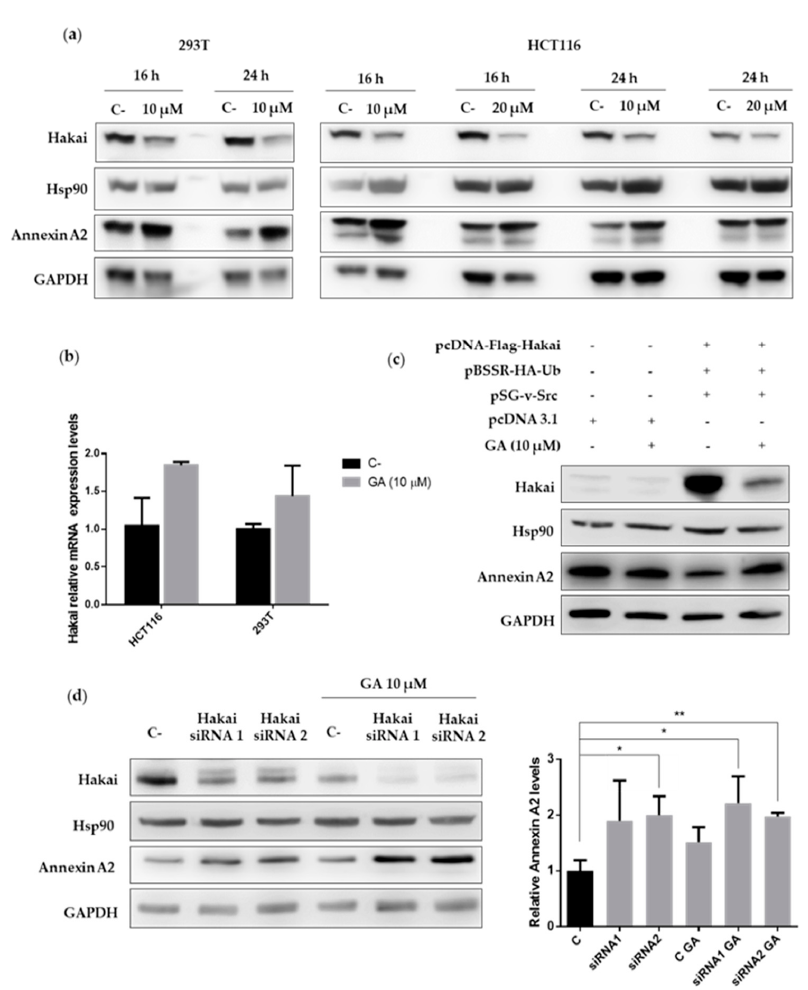
Figure 5. Geldanamycin reduces Hakai protein expression accompanied with an increase of Annexin A2: ( a ) HEK293T and HCT116 cells were treated with geldanamycin at the indicated times and concentrations. Cell lysates were collected and subjected to western blot analysis with the indicated antibodies. ( b ) HCT116 and HEK293T cell lines were treated with geldanamycin for 24 h at the indicated concentration. Cells were collected and subjected to mRNA extraction followed by RT-qPCR. Levels of Hakai mRNA normalized to control (HPRT) mRNA were measured and graphically represented as Mean ± SEM for three independent experiments (* p < 0.05, ** p < 0.01). ( c ) HEK293T cells were transiently transfected with pcDNA 3.1 (10 µg) empty vector or pcDNA-Flag-Hakai (4 µg), pBSSR-HA-ubiquitin (3 µg) and pSG-v-Src (3 µg) plasmids for 48 h. Cells were treated with 10 µM geldanamycin 24 h after transfection. Cells were collected and protein levels were evaluated by western-blotting with the indicated antibodies. ( d ) HCT116 cells were transfected with Hakai siRNA-1 and siRNA-2 oligos for 72 h and treated with 10 µM geldanamycin for the last 24 h of transfection. Cell lysates were collected and protein expression was evaluated by western-blotting with the indicated antibodies. Relative quantification of Annexin A2 expression levels was graphically represented as Mean ± SEM for three independent experiments (* p < 0.05, ** p < 0.01). As previously mentioned, Hakai is an E3 ubiquitin-ligase for E-cadherin that plays a role on the